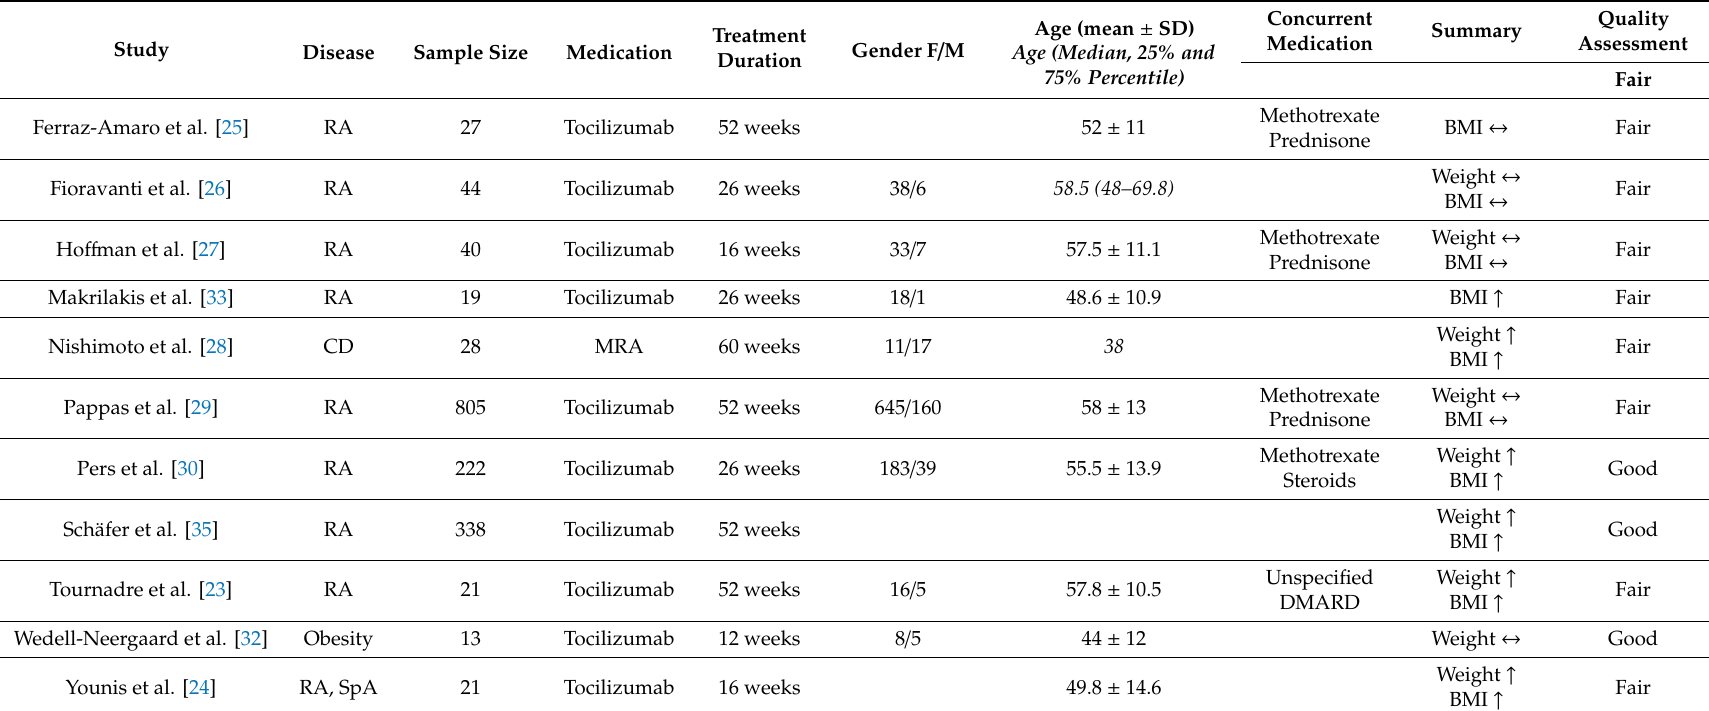
Table 1. Study characteristics of included